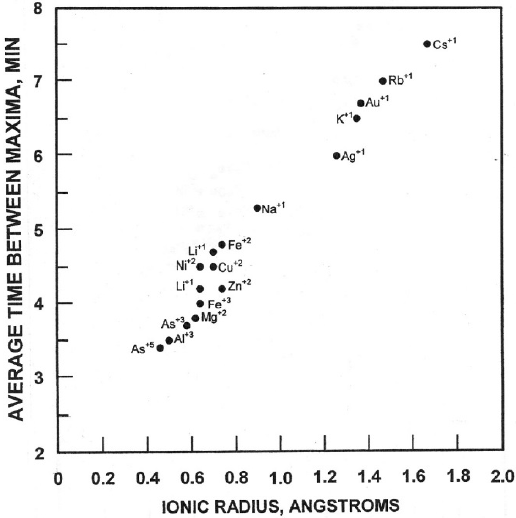
Figure 9. Period length of the oscillations of an aqueus solution is directly proportional to the ionic radius of the cation present and independent of cation concentration. All solutions were tested as the chloride at a final concentration of 10 µM. Only with Cu 2+ (replaceable by Ni 2+ ) was the asymmetric period length of 24 min observed. Reproduced from Morré and Morré [3] with permission from